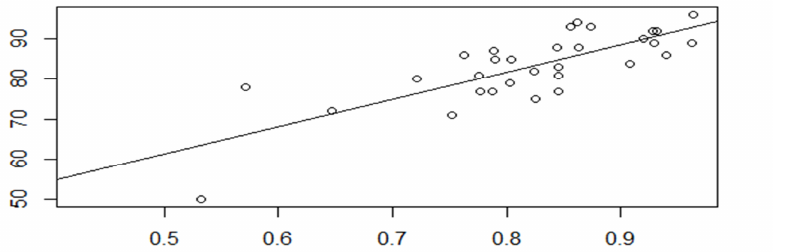
Figure 1: Internet Usage (Digital Agenda) Versus Individuals’ Level of Internet Skills (Eurostat)